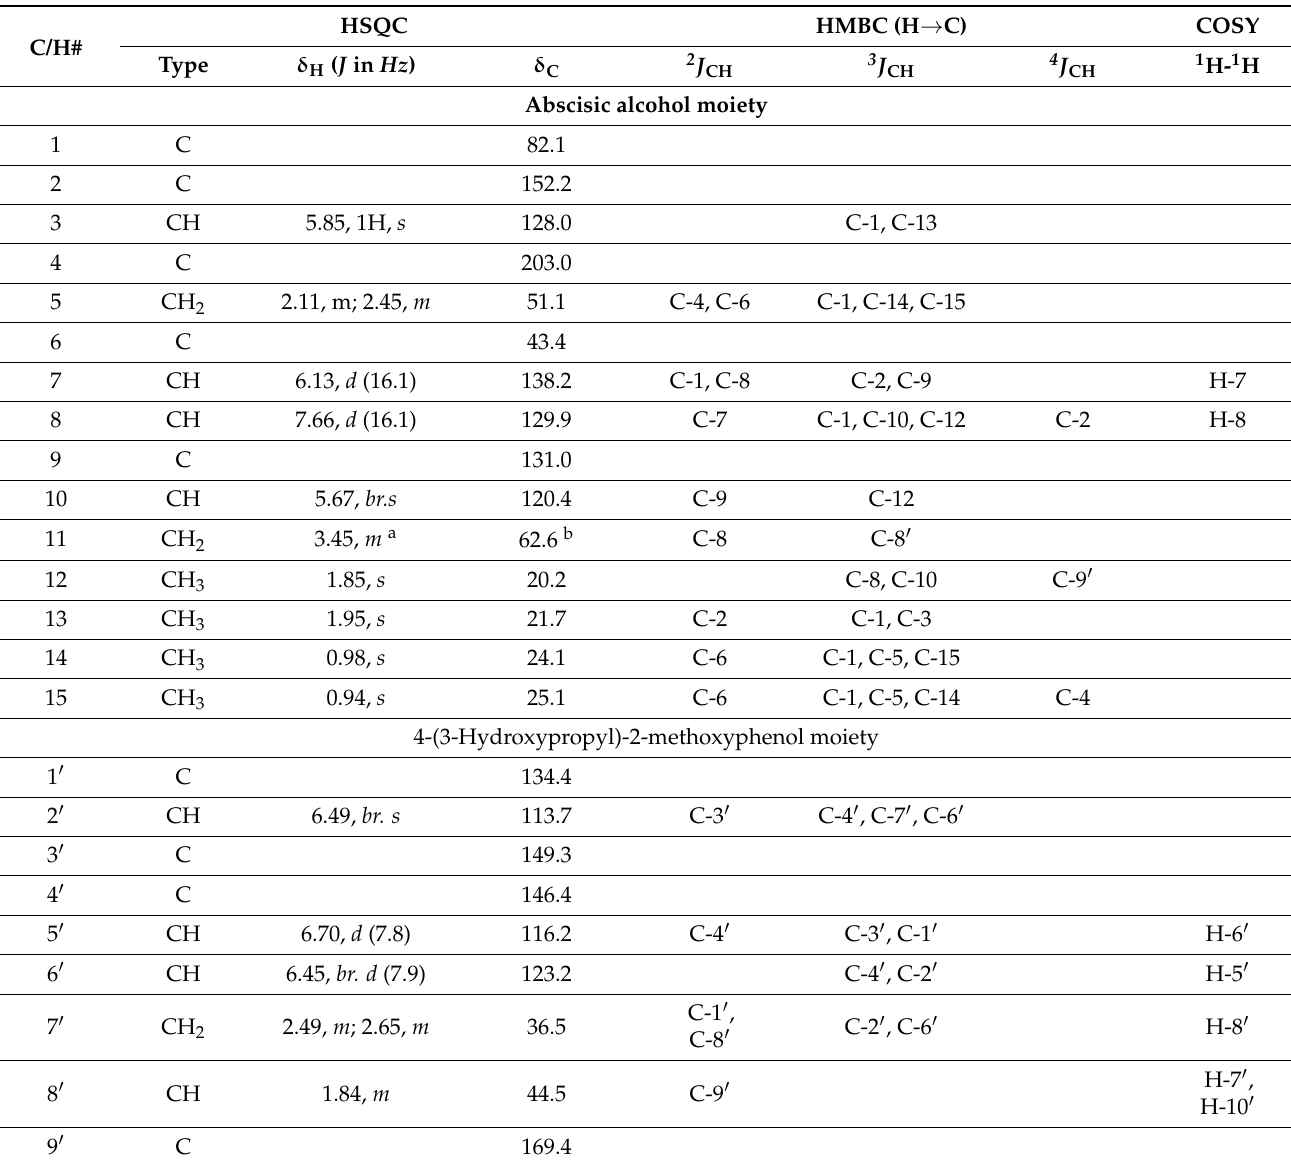
Table 2. NMR spectral data of compound C5 in CD 3 OD (500 MHz for 1 H- and 125 MHz for 13